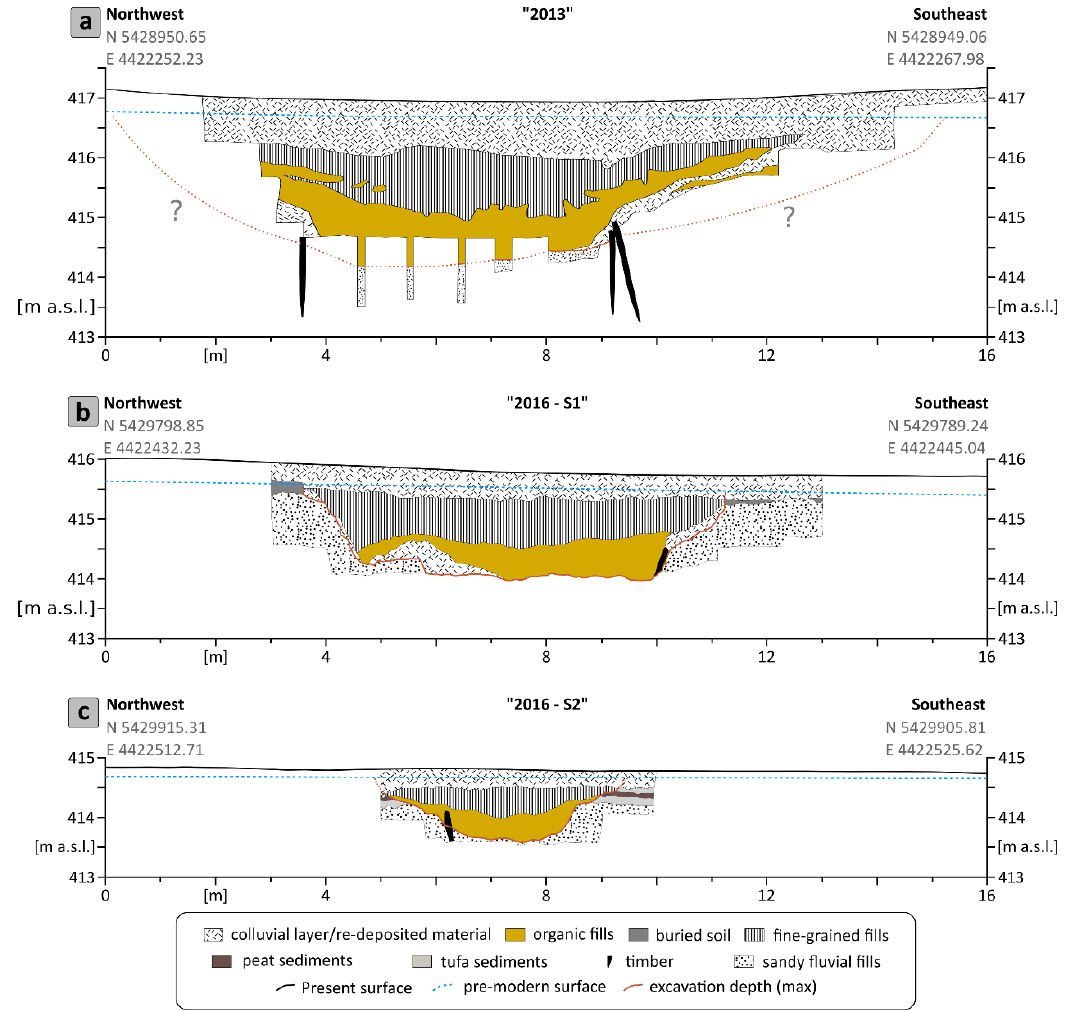
Figure 8: Archaeological excavation reference geometries. a ) “2013”, b ) “2016 – S1” and c ) “2016 – Figure 8. Archaeological excavation reference geometries. ( a ) “2013”, ( b ) “2016–S1” and ( c ) S2”.